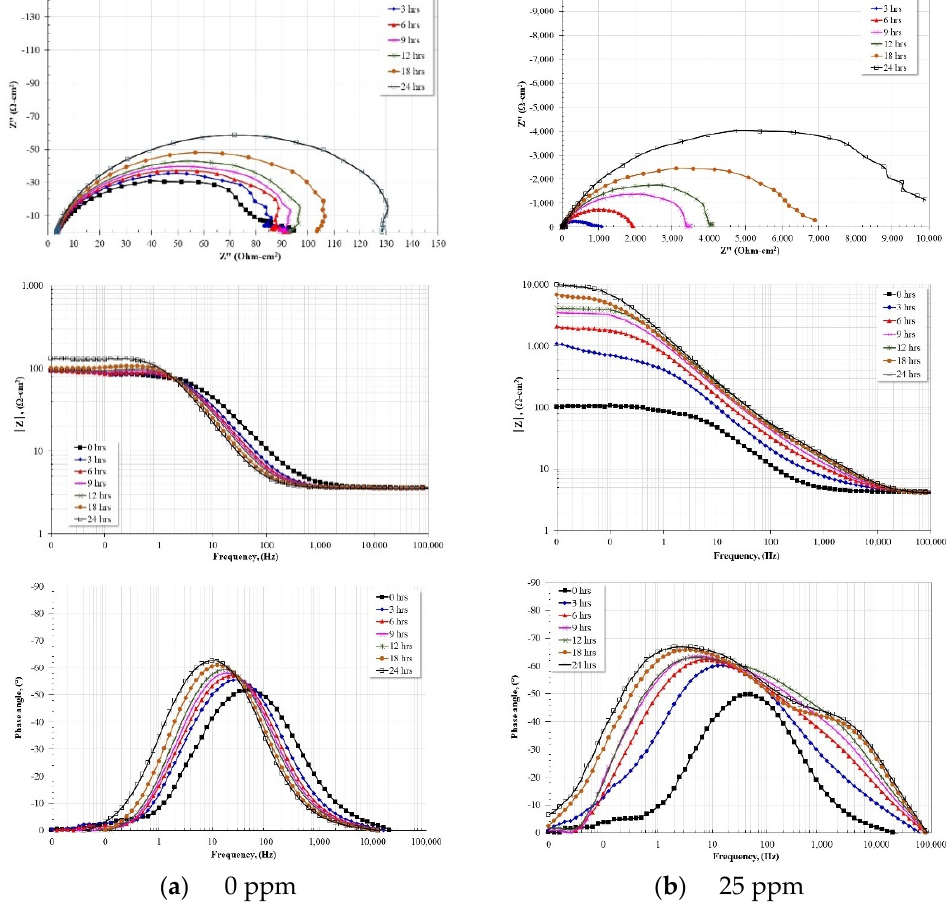
Figure 5. ( a ) Nyquist and Bode plots for API-X52 steel in CO 2 -saturated brine a 60 °C. ( b ) Nyquist and Bode plots for API-X52 steel in CO 2 -saturated brine a 60 °C and 25 ppm of